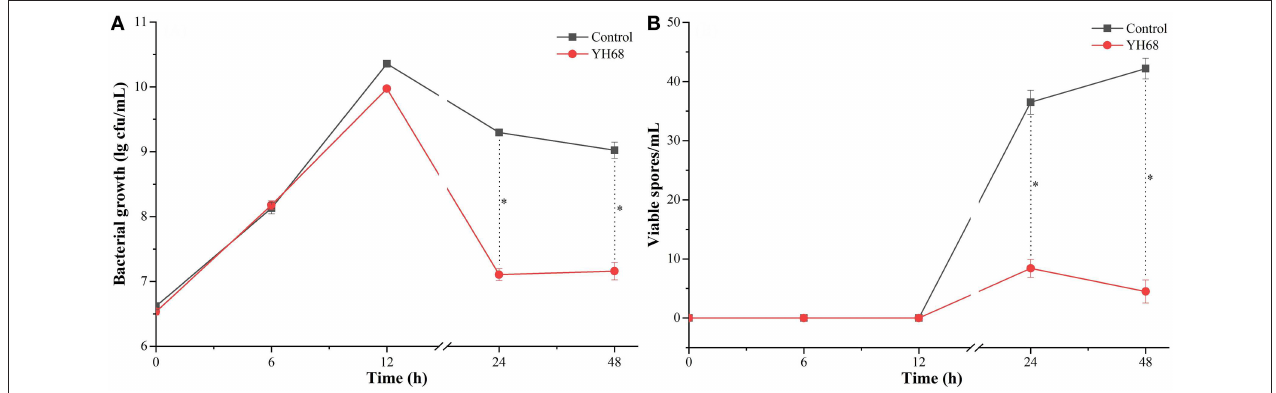
FIGURE 1 | Bacterial growth and viable spores of C. difficile ATCC 9689 at different time points. (A) Bacterial growth lg cfu/mL; (B) Viable spores/mL (control and YH68 at the same time point; * P < 0.05; Student’s t -test).